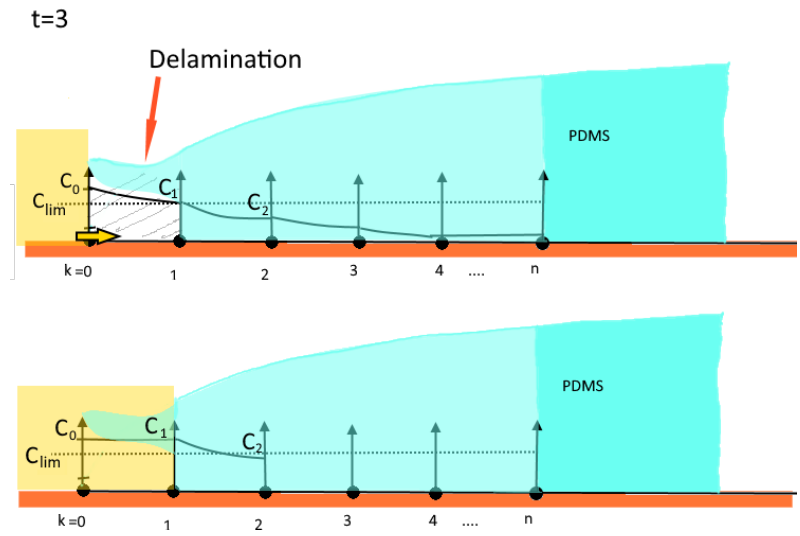
Figure 11. Corrosion in the first element has progressed so far that at t = 3 the PDMS begins to delaminate from the copper substrate. In this way a cavity is formed allowing the corroding agent to flow under the separated PDMS. Subsequently, the corroding agent directly affects the next element leading to a jump in concentration. This marks the beginning of the conversion of the curve from a saturation-like shape into a linear-like behaviour.